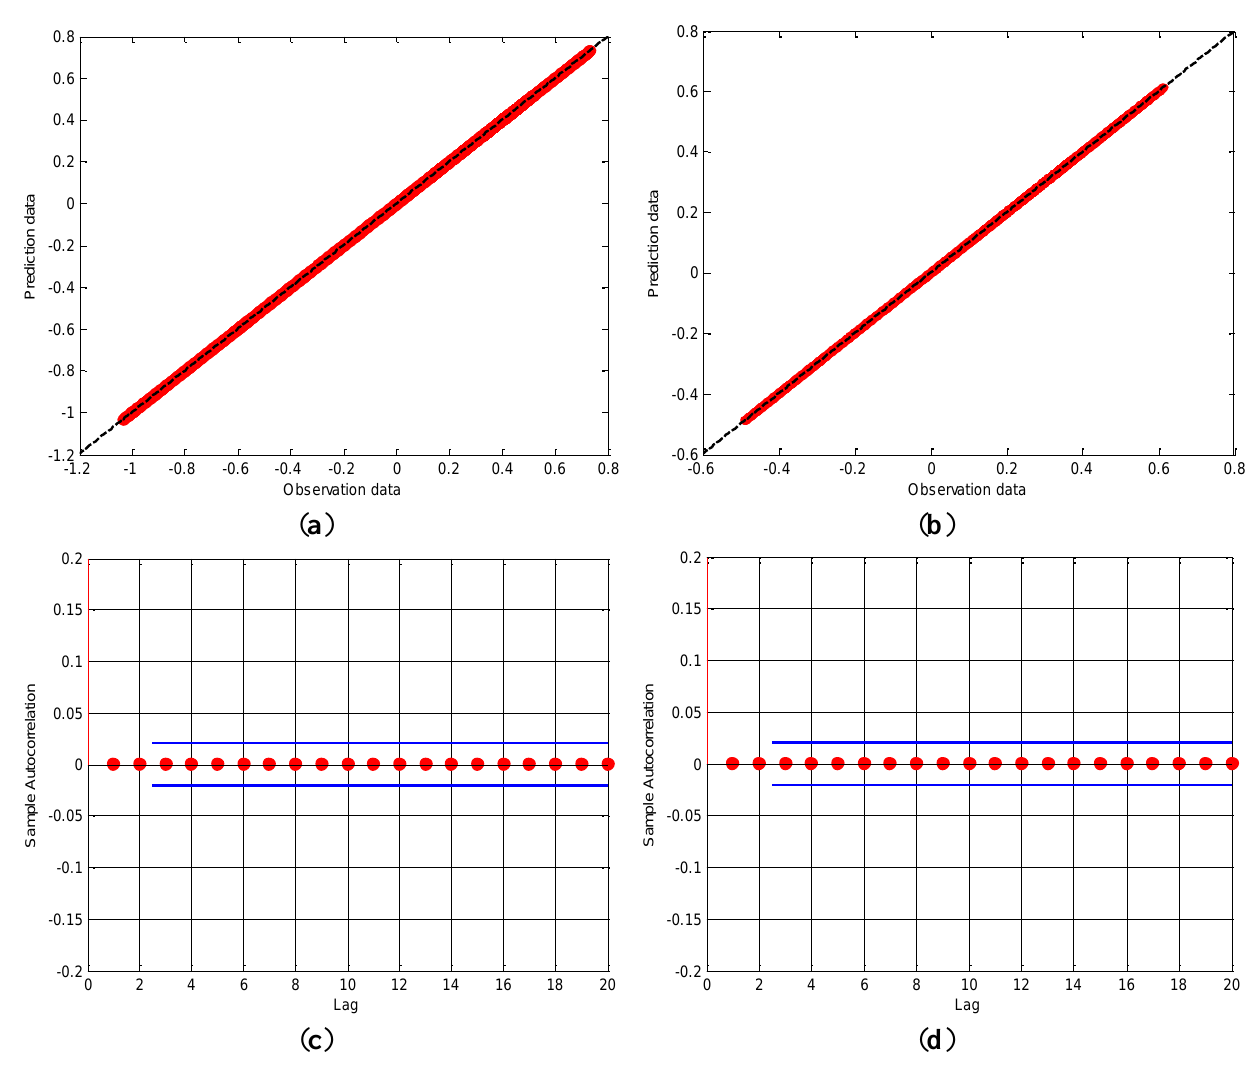
Figure 13. TheANFISPrediction movement performance on ( a ) 15 Sept.; ( b ) 25 Sept. and ACF for the check time on ( c ) 15 Sept.; ( d ) 25 Sept. of ANFIS model